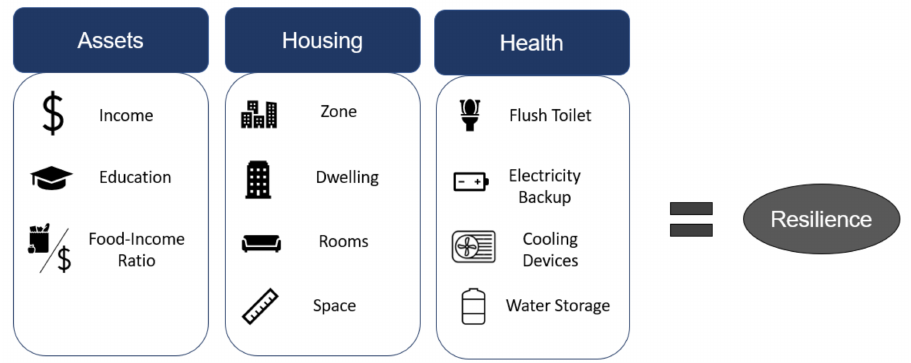
Figure 2. Resilience model framework describing how resilience is calculated based on the three pillars: assets, housing, and health as well as their associated